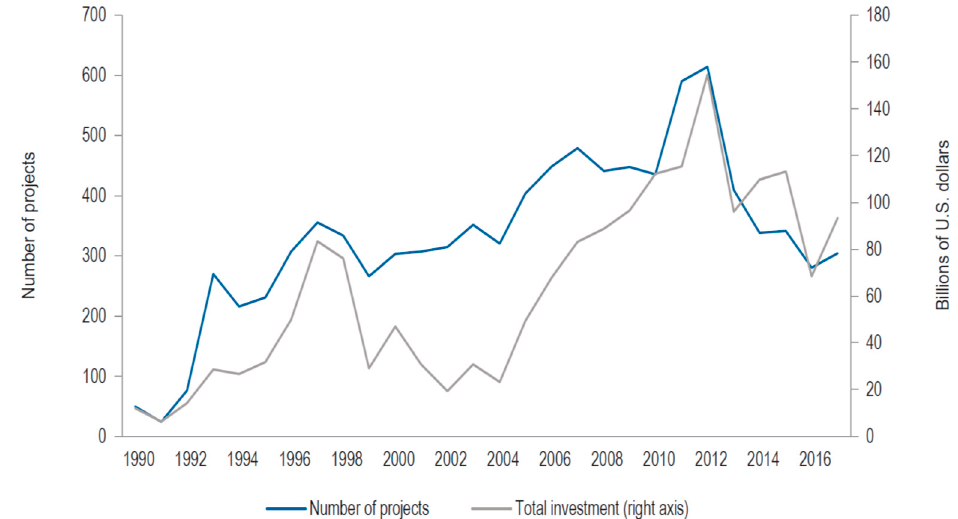
Figure 2. Number of projects and total investment in PPPs in emerging economies. Source: Hey- dari et al. [7].